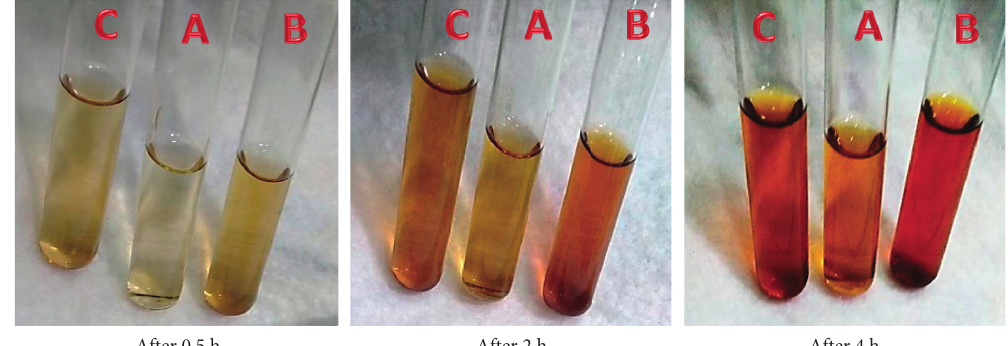
Figure 1: Visual color change of biosynthesized Se-NPs using cinnamon extract after incubation of 10mM of Na (B), and 1.5% (C) from the extract for 0.5, 2.0, and 4.0h at 25 ° C.